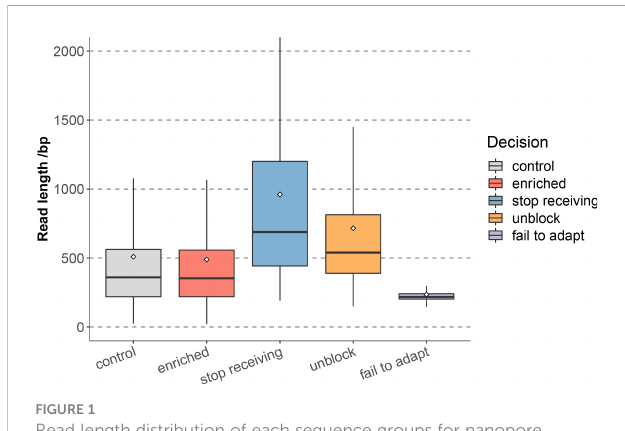
FIGURE 1 Read length distribution of each sequence groups for nanopore adaptive